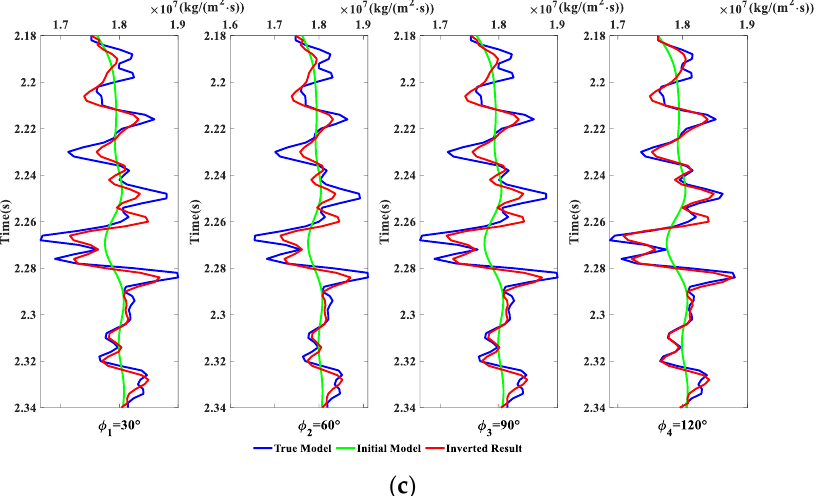
Figure 3. The estimated azimuthal EI of three angles and four azimuths without noise, where ( a )